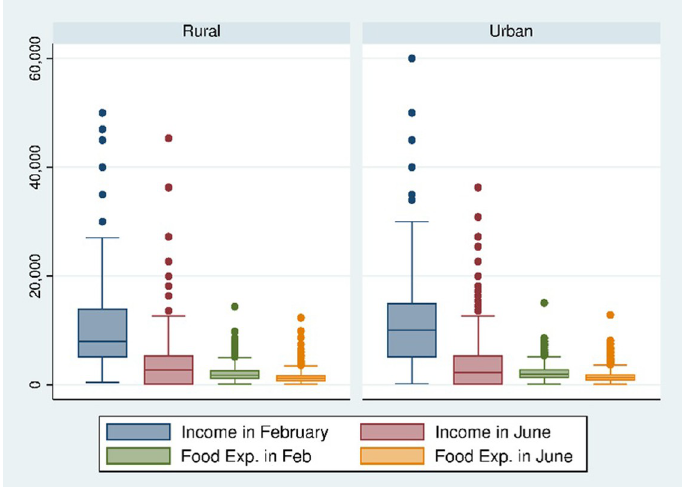
Fig 2. Box-plots for numerical income and food expenditure